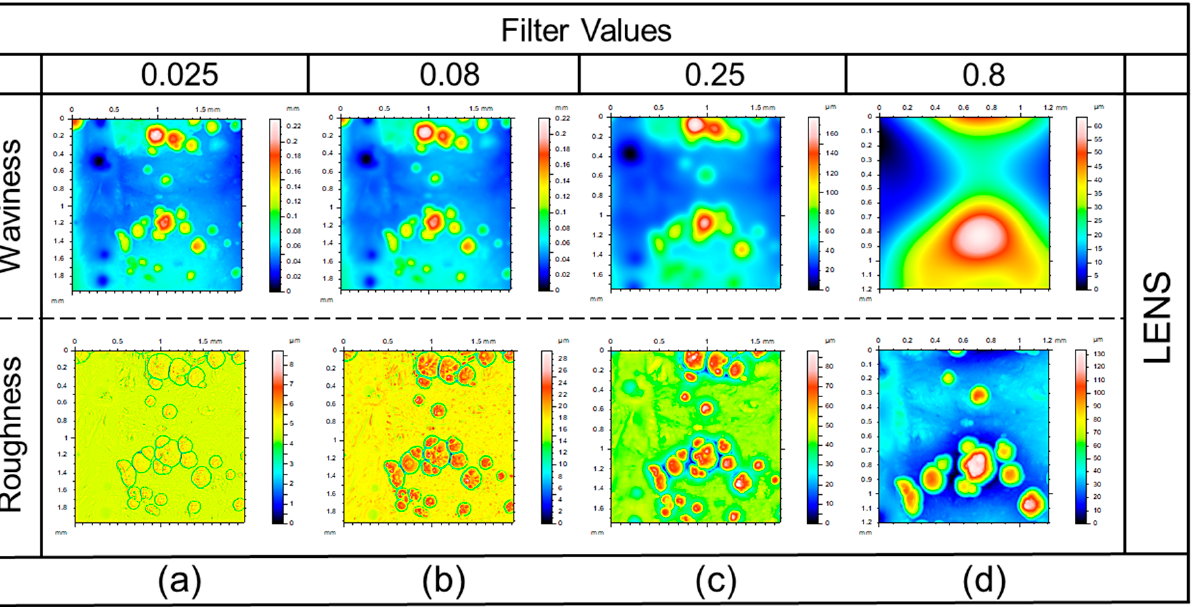
Figure 11. Surface topography of as-built LENS surface after filtering.